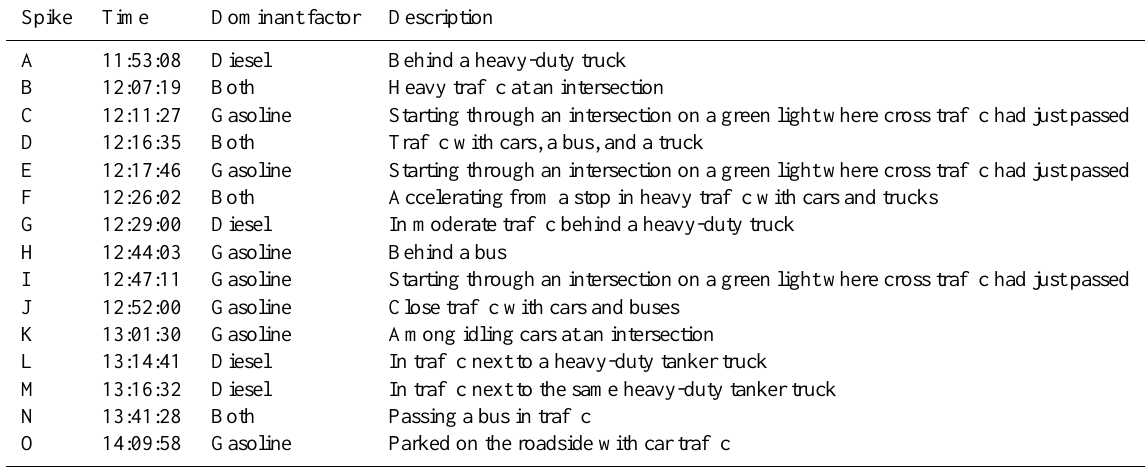
Table 2. Description of video during spikes labeled in Fig.